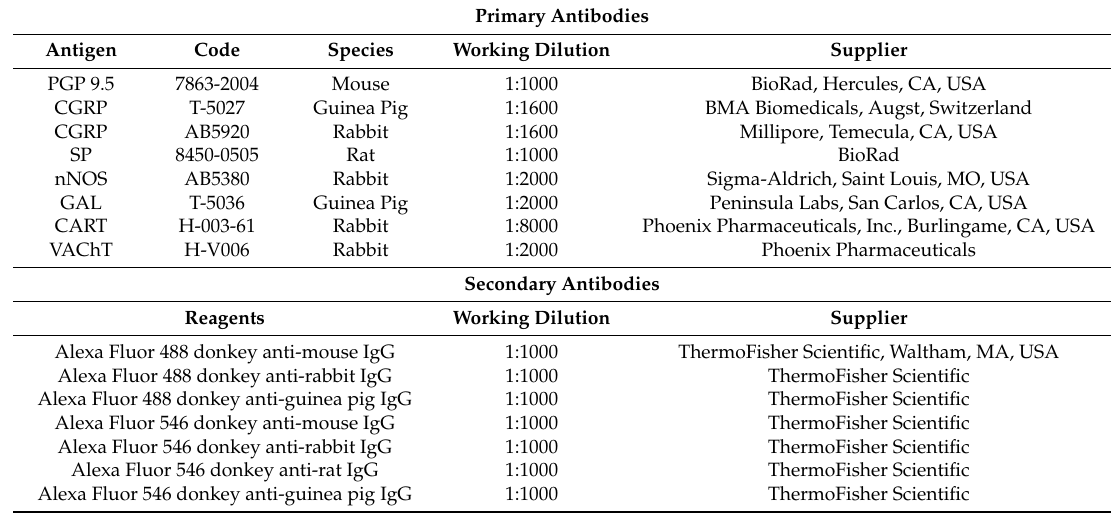
Table 7. The list of antisera and reagents used in immunohistochemical